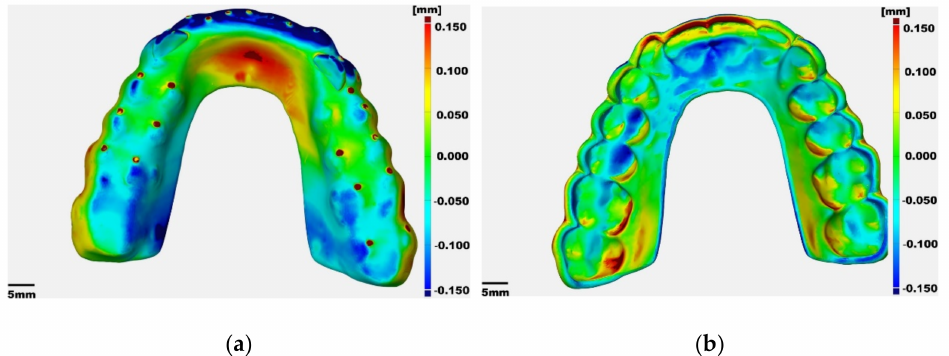
Figure 2. Representative example of the surface deviations of [2.5_TOTAL] (Scale ± 150 µ m) from the reference data file with respect to the; ( a ) external surface; ( b) internal surface.